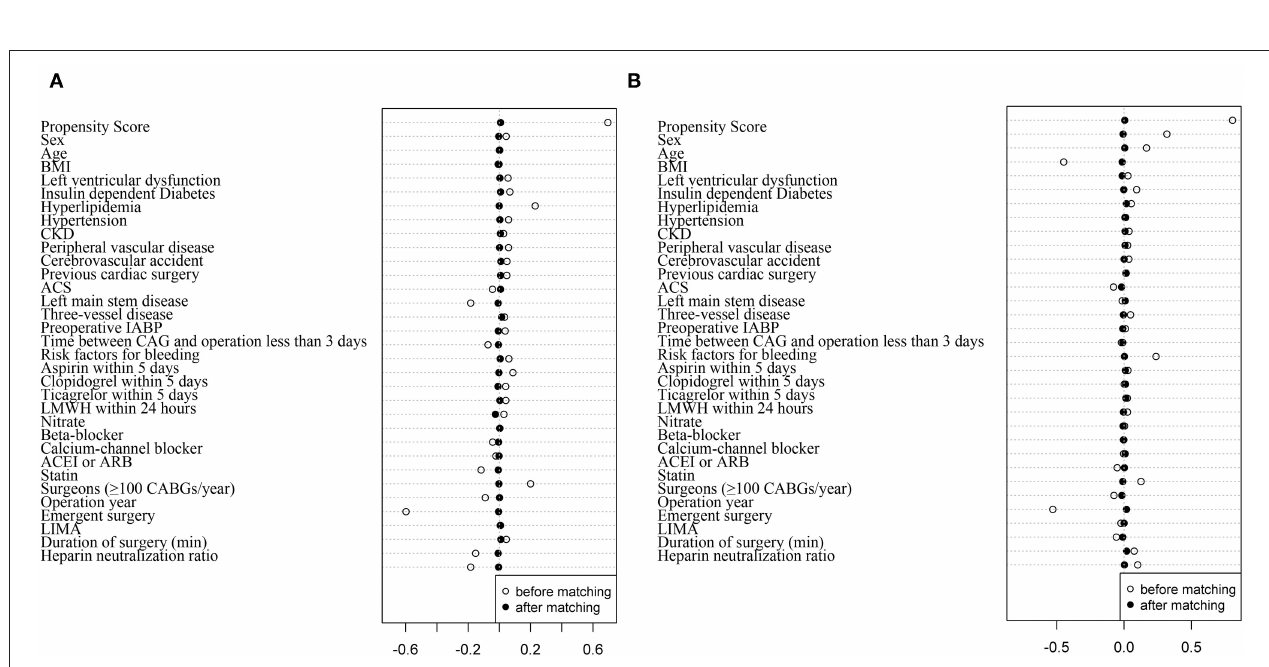
FIGURE 2 | Propensity score matching in patients with OPCAB between the TXA and no-TXA groups and the high-dose and low-dose subgroups. (A) The propensity score matched well between the TXA and no-TXA groups. The standardized difference was < 0.1 in all 32 covariates. (B) The propensity score matched well between the high-dose and low-dose subgroups. The standardized difference was < 0.1 in all 32 covariates.